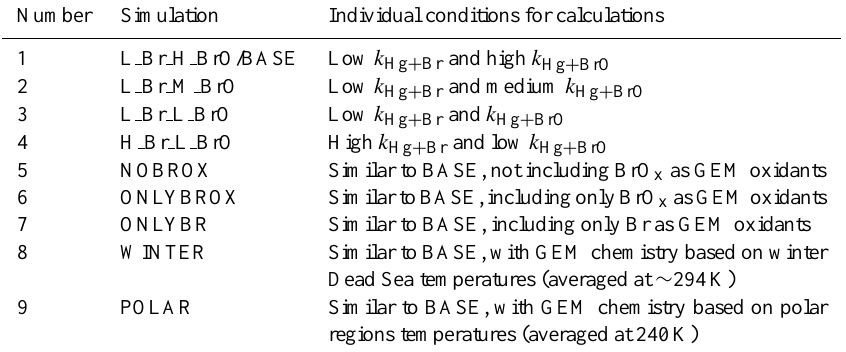
Table 2. Key to different simulation types. Simulations 1–4 were performed for four different days from the measurement campaign (Julian days 188, 197 and 201) using different combinations for the rate of Hg with Br and BrO: low and high k Hg + Br ( = 2 . 7 × 10 − 13 and 1 . 1 × 10 − 12 × (T/ 298 ) − 2 . 37 cm 3 molecule − 1 s − 1 ) for “L Br” and “H Br”, respectively, based on Donohoue et al. (2006) and Goodsite et al. (2004); k Hg + BrO = 1 × 10 − 15 and 5 × 10 − 14 cm 3 molecule − 1 s − 1 for “L BrO” and “M BrO,” respectively, based on Raofie and Ariya (2003); and k Hg + BrO = 1 . 5 × 10 − 13 cm 3 molecule − 1 s − 1 for “H BrO”. “L Br H BrO”, is referred to as “BASE” simulation due to best agreement with measurements. Simulations 5–10 were performed for Julian days 188 and 201 which represent typical days of relatively high Dead Sea BrO levels (see additional details in Sect. 3.1). Number Simulation Individual conditions for calculations